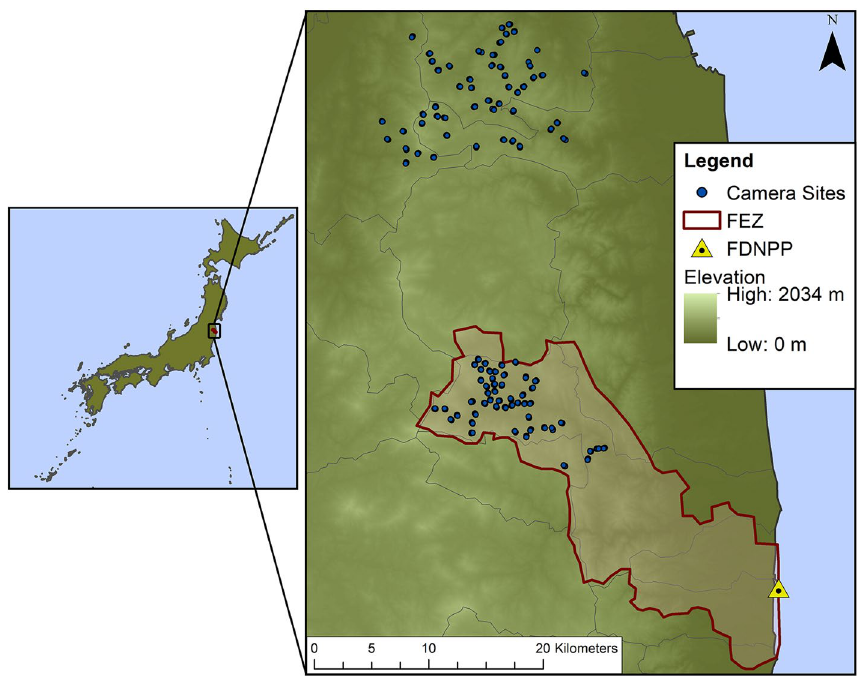
Figure 1. Map of camera sites used for scavenging trials in and around the Fukushima Exclusion Zone (FEZ) in relation to the Fukushima Daiichi Nuclear Power Plant (FDNPP). Inset map includes the location of the FEZ within Japan. This figure was created using ArcMap 10.8.1 (https:// www. esri. com/ en- us/ arcgis/ produ cts/ arcgis- deskt op/ resou